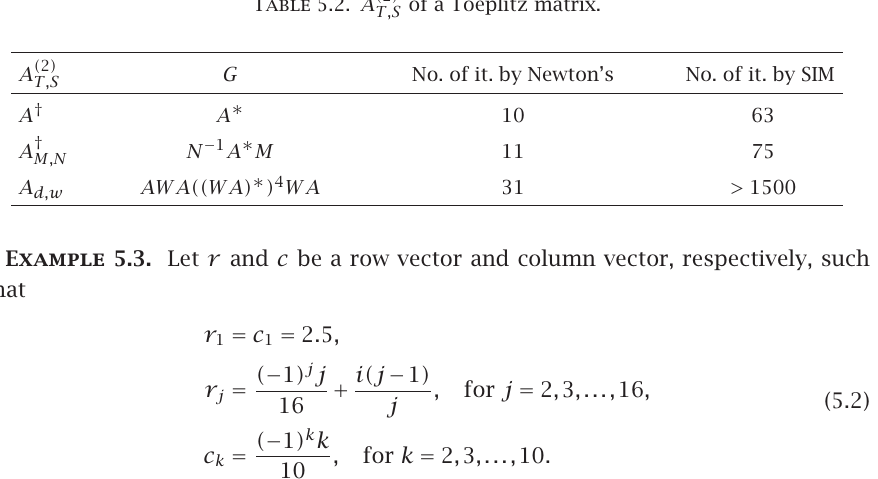
Table 5.2 . A ( 2 ) T,S of a Toeplitz